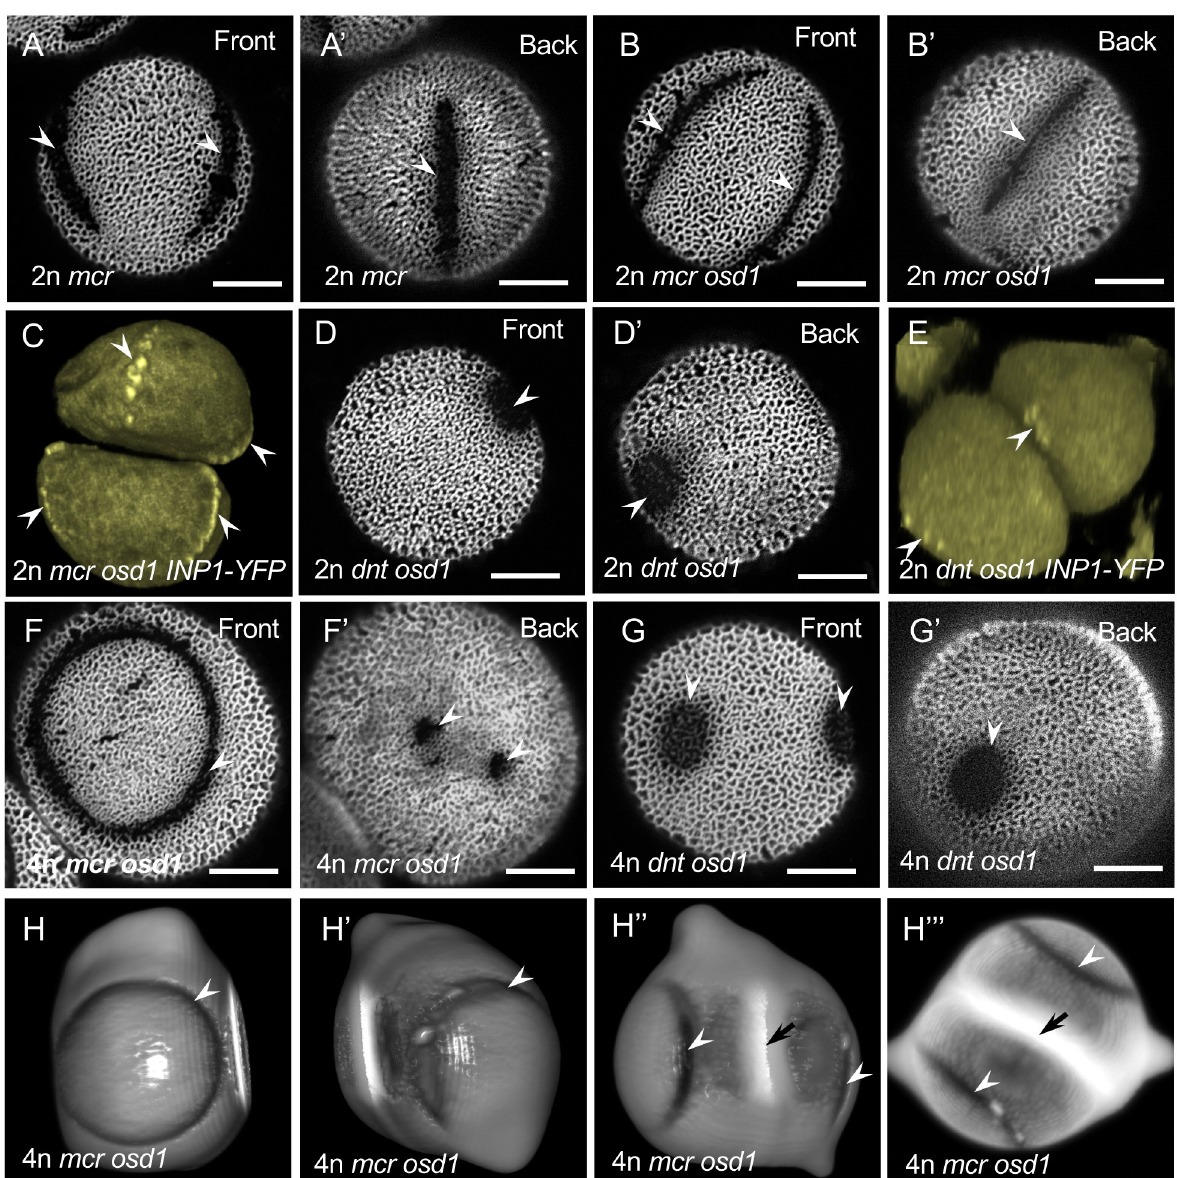
Fig 9. Effects of changes in pollen ploidy/size on pollen aperture patterns in the mcr and dnt mutants. (A-B’) Diploid mcr pollen forms three apertures (arrowheads), independently of the meiotic product arrangement. (A-A’) Front and back views of the 2n mcr pollen produced by a 4n plant through a tetrad formation. (B-B’) Front and back views of the 2n mcr osd1 pollen produced through a dyad formation. (C-C’) Diploid pollen of dnt osd1 , similar to the haploid dnt pollen, usually has two round apertures (arrowheads). See also S7 Video. (D) INP1-YFP forms three longitudinal lines (arrowheads) in diploid mcr osd1 dyads. A 3D reconstruction of a mcr osd1 INP1-YFP dyad is shown. See also S8 Video. (E) INP1-YFP forms puncta at the proximal and distal poles of microspores in diploid dnt osd1 dyads. A 3D reconstruction of a dnt osd1 INP1-YFP dyad is shown. See also S9 Video. (F-F’) Increase of pollen ploidy in mcr osd1 to 4n most commonly leads to the formation of a ring-like aperture on one side of the pollen grain (F, arrowhead) and one or several hole-like apertures (F’, arrowhead) on the other side. (G-G’) Increase of pollen ploidy in dnt osd1 to 4n usually increases the number of round apertures to more than two. (H-H”’) The ring-like apertures (arrowheads) in the 4n mcr osd1 dyads are located on the distal end of each microspore, thus placing the hole-like apertures at the proximal end, near the intersporal callose wall (black arrows). Shown are different views of a 3D reconstruction of a late-stage dyad (H-H”) and a maximum intensity projection of a confocal z- stack of the same dyad (H”’) See also S10 Video. Scale bars = 10 μ m.